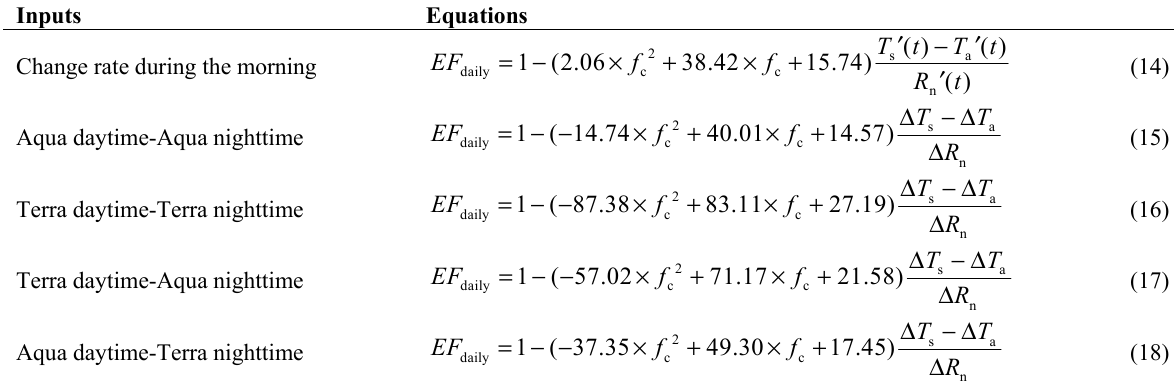
Table 3. Equations of daily EF estimates for different input schemes.